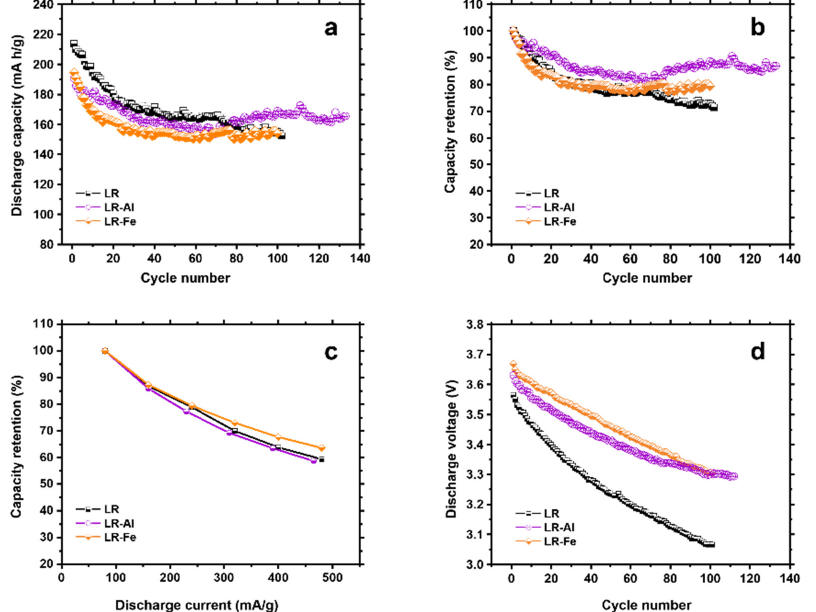
Figure 8. Electrochemical performance of LR, LR-Al, and LR-Fe: ( a ) the discharge capacity as a function of cycle number at the current densities of 80 mA/g; ( b ) the capacity retention vs. cycle number at 80 mA/g; ( c ) rate performance; and ( d ) average discharge voltage fade as a function of cycle number.